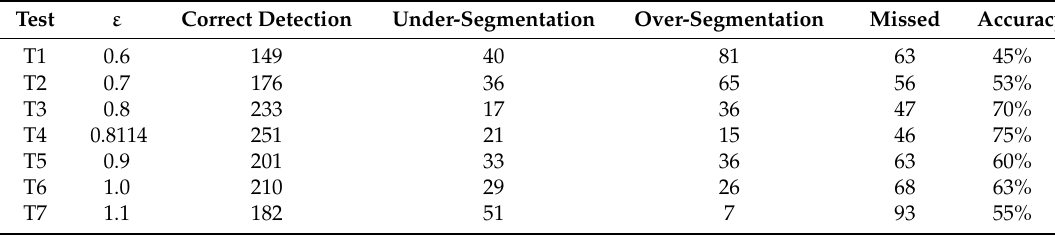
Table 2. Accuracy evaluation using different ε for airborne laser scanning data using X , Y , Z fields.